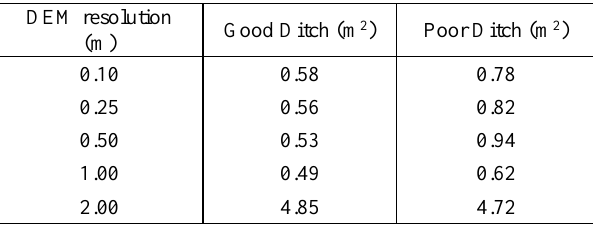
Table 1. The standard error of mean ditch sizes in different